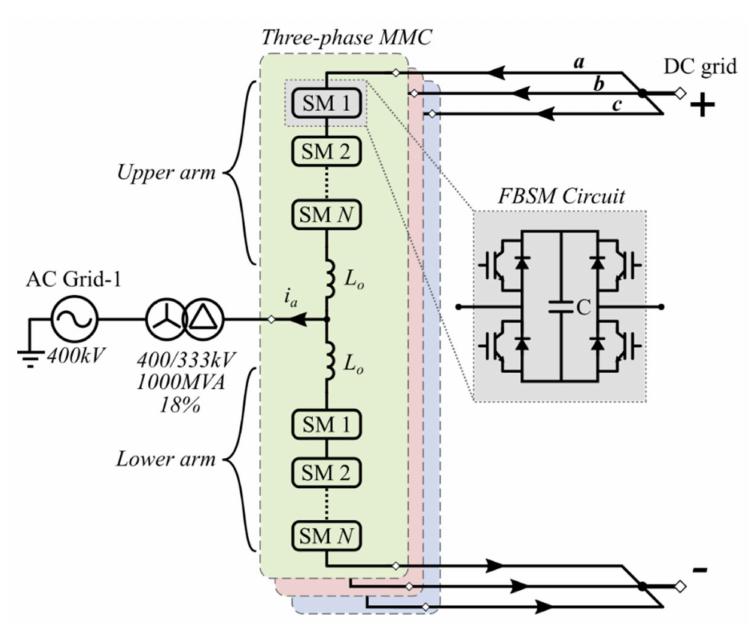
Figure 1. A mesh-connected four-terminal MMC system.